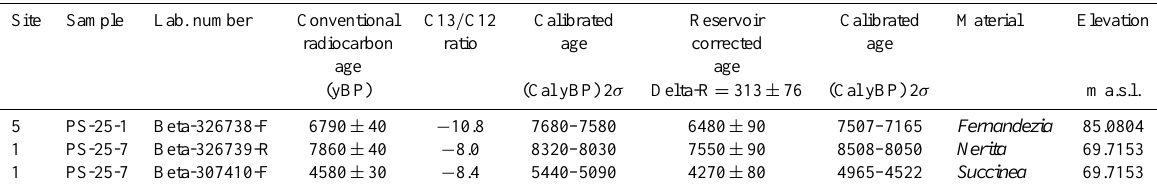
Table 1. Radiocarbon dates for gastropods from Robinson Crusoe Island. Data obtained at Beta Analytic Inc., Miami, FL. Elevation computed from dGPS data with correction for daily variation of sea level and local height of the antenna.